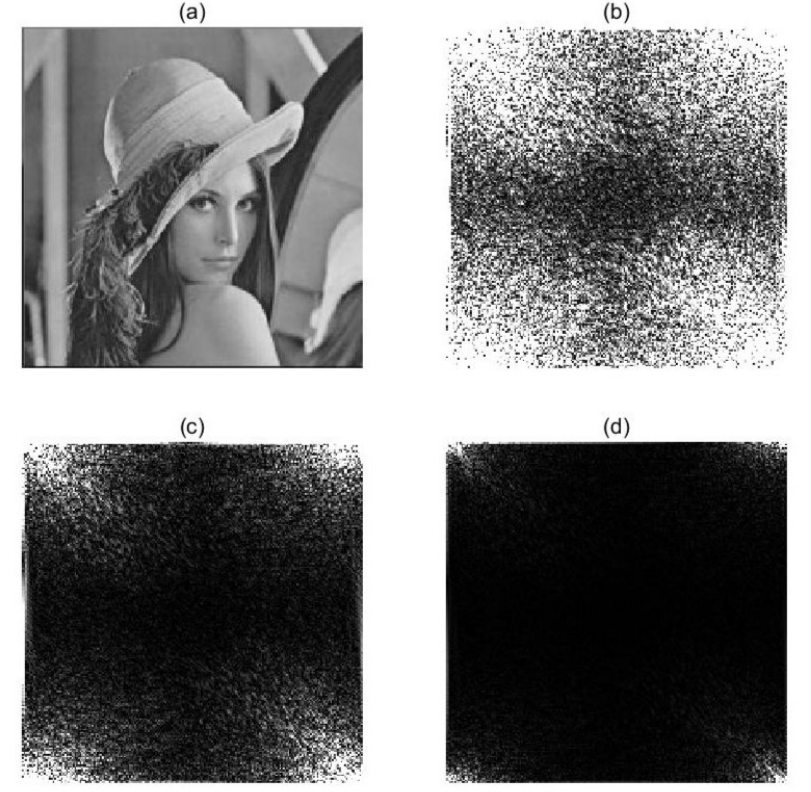
Figure 7. ( a ) Original image, ( b ) 2D-LCT images of A , ( c ) 2D-LCT images of B , and ( d ) 2D-LCT images of C